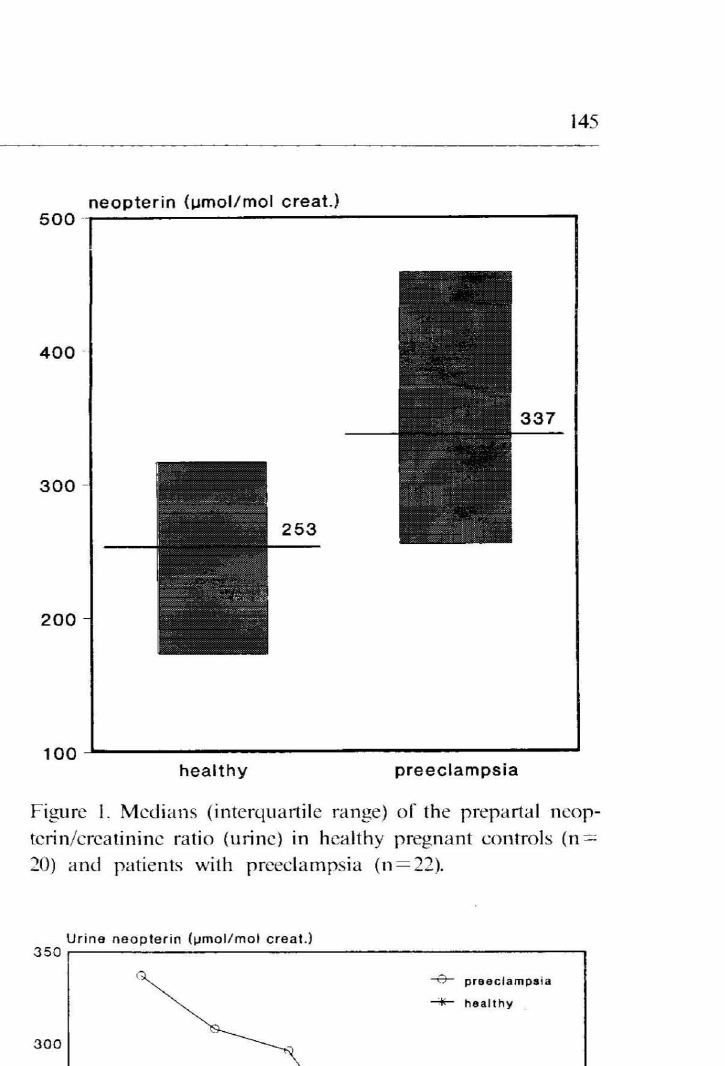
Figure I. Medians (interquartile range) of the prepartal neop terin/creatinine ratio (urine) in healthy pregnant controls (n=' 20) and patients with preeclampsia (n = 22).